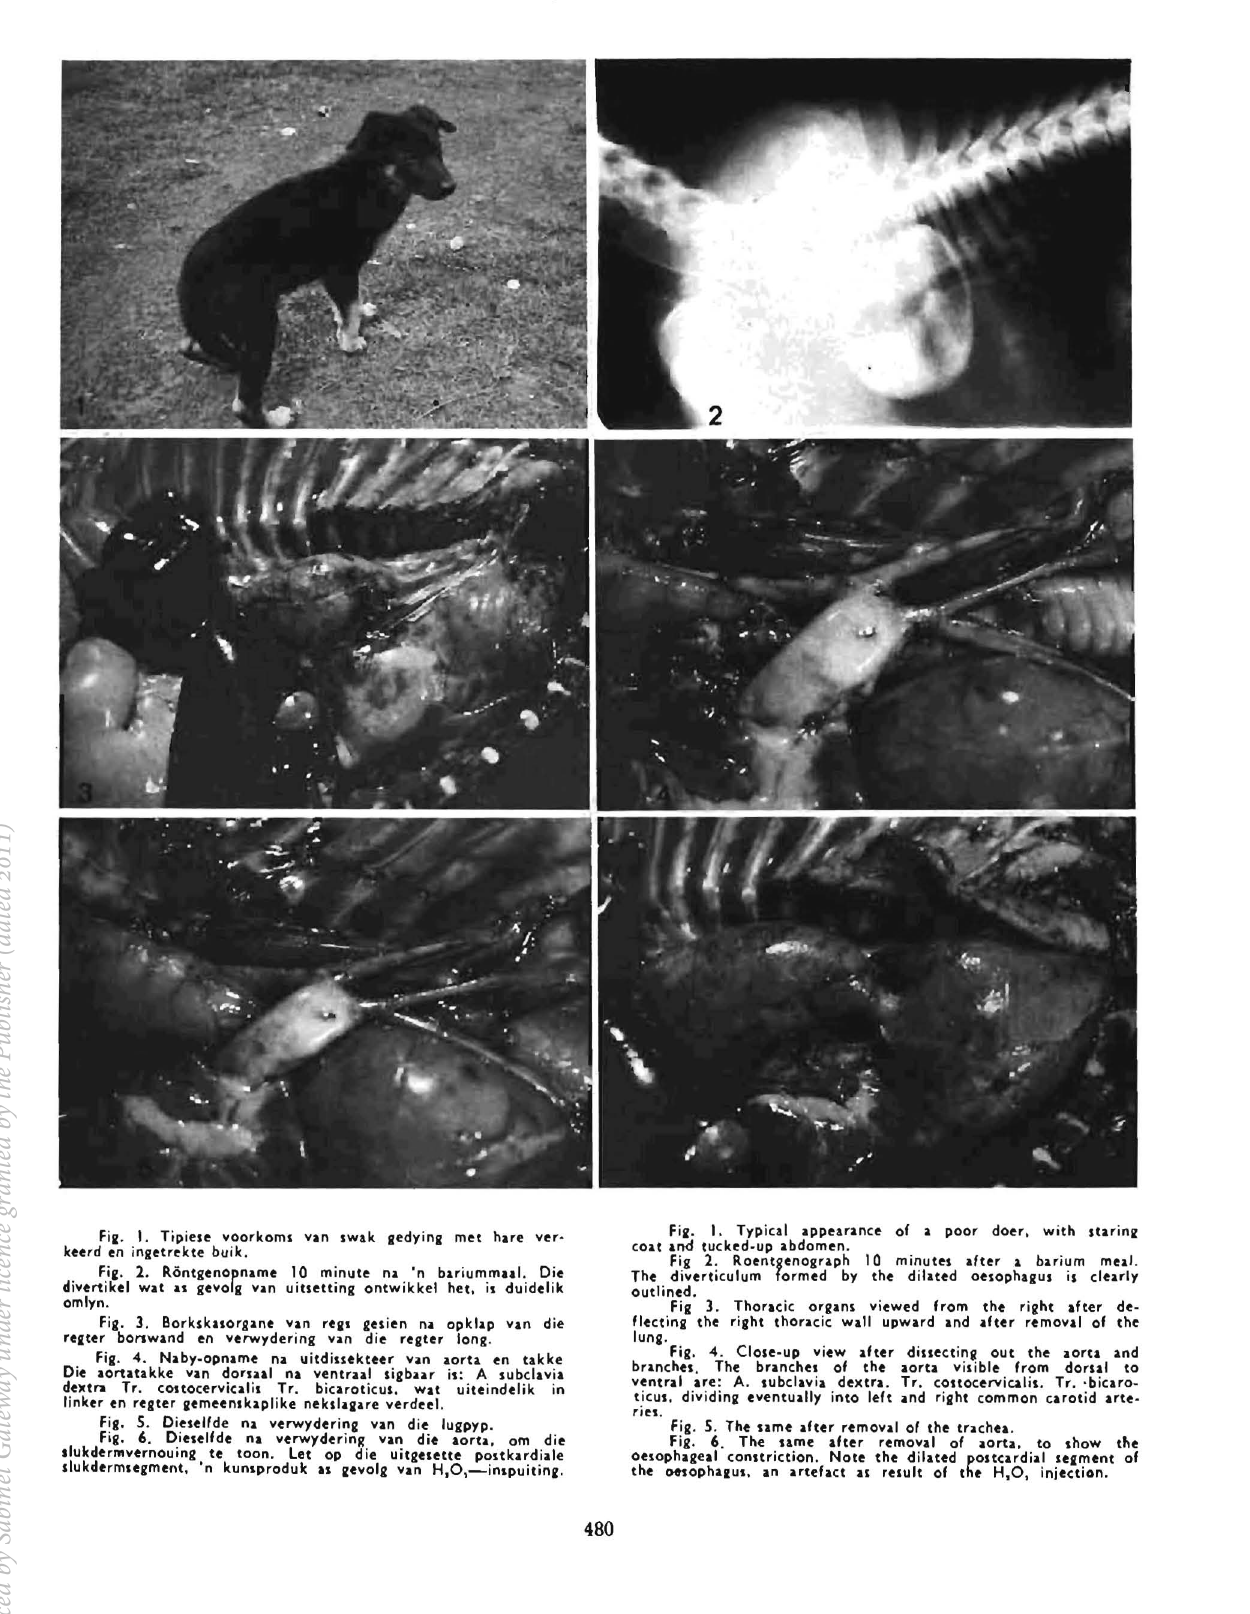
Fig. 3. Borkskuor,9:ane Yan regs gesien nil opkb.p van die reiter bonwlnd en vtrwydering Y.an die rtgter long. Fig. 4. N.1by-opnlme nJ. uitdiuekteer Yin aorta. en ukke Die aortatakke van dorual nil ventr,n,1 sigbJ.ilr is: A subclavia de)(t~ Tr. cOHocerviu.lis Tr. bicaroticul. wat uittindelik in linker en rtgter Kemeenskaplike nekslilKHe vtrdeel. fig. S. Di~I~lIde n. v~rwyd~ring von di~ 'ugpyp. Fig. 6. DifstUde na verwydering YIn die iloru., om die Ilukdermvernouing te toon. let op die uitgesette poukardiJ,le slukdermltement. In kunsproduk II it-volg Vln H,O,-inspuitinr.